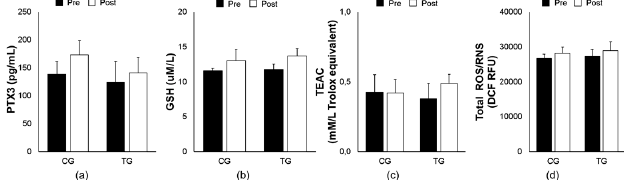
Figure 1. Effects of an 8-week aerobic training on plasma PTX3 ( a ) and oxidative biomarkers (GSH ( b ), TEAC ( c ), and total ROS/RNS ( d )) in both trained (TG) and control (CG) groups. Data are means ± SEM. GSH, reduced glutathione; PTX3, pentraxin 3; ROS/RNS, reactive oxygen/ nitrogen species; TEAC, trolox equivalent antioxidant capacity.